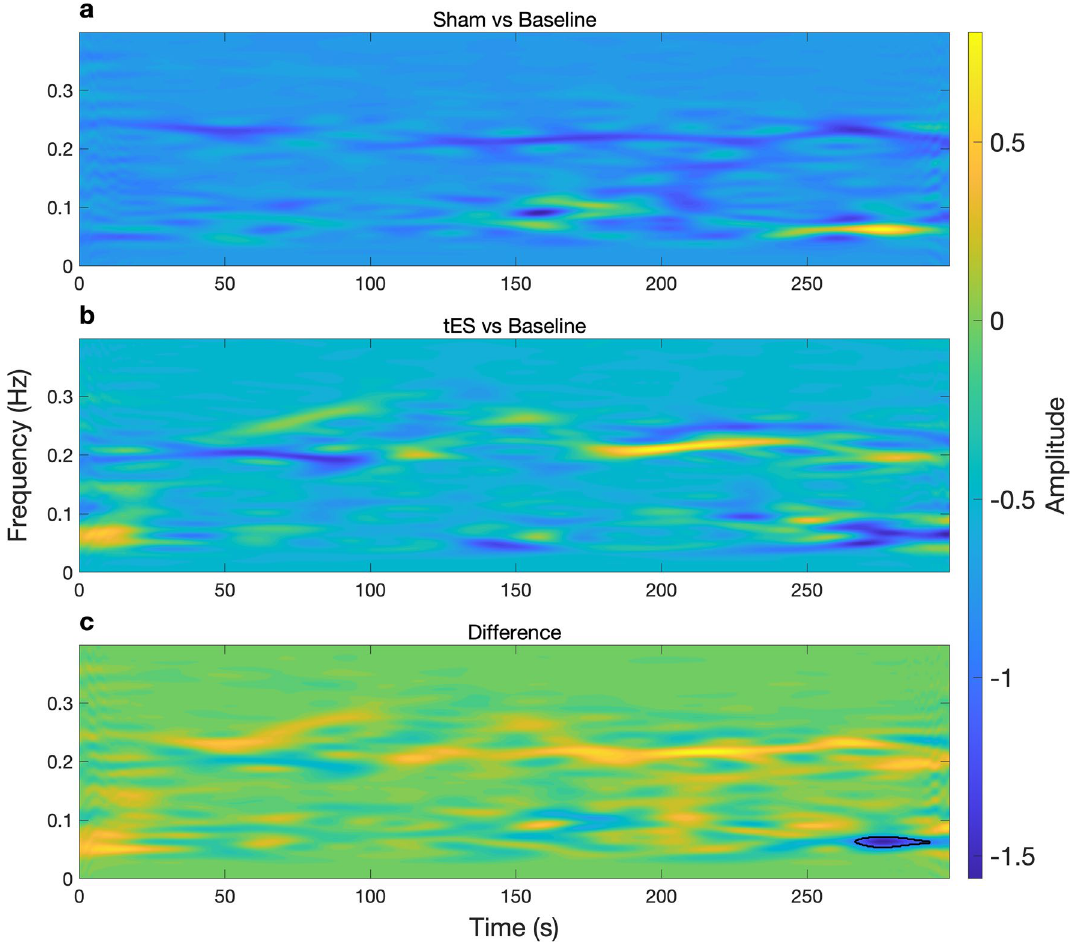
Figure 2. Time-varying power representations of heart rate variability (HRV) using the smoothed pseudo Wigner–Ville distribution (SPWVD) for an example participant. (a) Time-frequency power during sham (baseline subtracted) condition (b) and tES (baseline subtracted) condition. (c) Shows the time-frequency power difference between (Sham vs Baseline) and (tES vs Baseline). A statistical pixel-based permutation test using a pixel-level significance threshold of p < 0.05 revealed 1 cluster around 270–290 s (two-tailed non- parametric permutation tests). The significant cluster (region) is outlined by a black contour in (c)